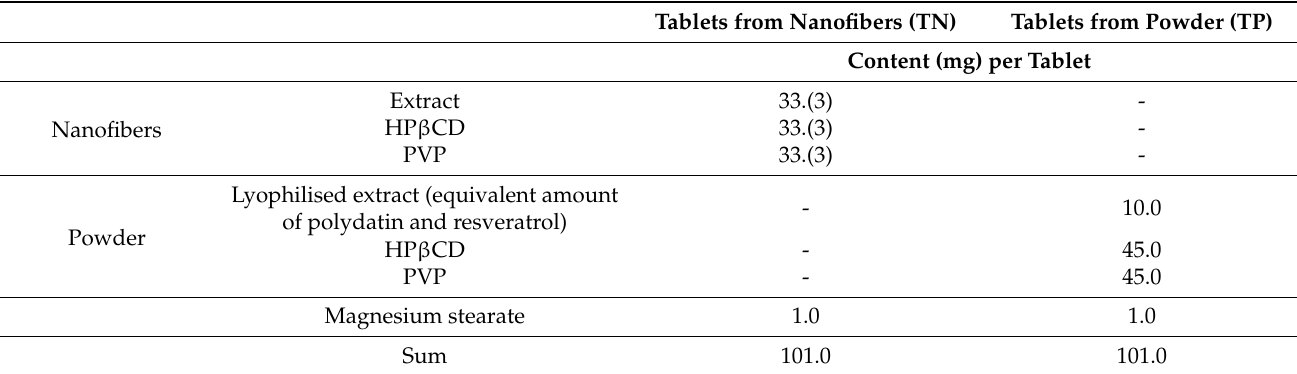
Table 4. The composition of tablet